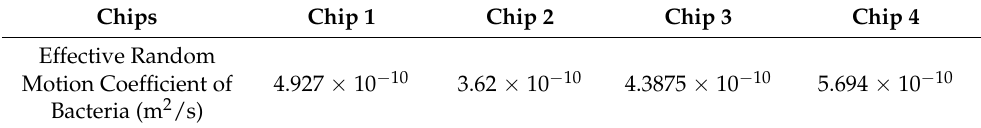
Table 3. Effective random motion coefficient of bacteria in different models. Chips